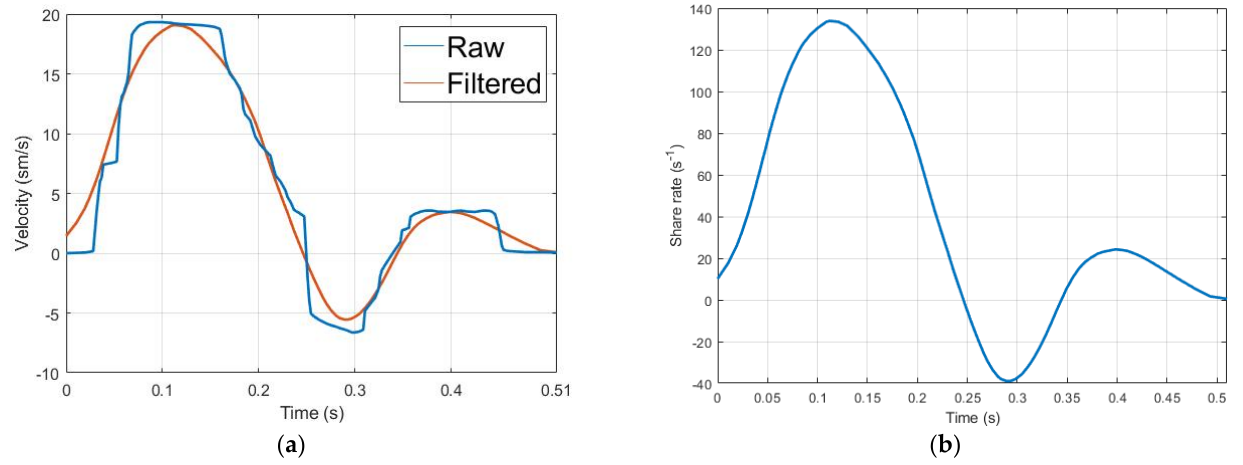
Figure 7. The red blood cells’ orientation effect estimation; ( a ) the averaged and smooth arterial blood velocity curve; ( b ) blood share rate curve.